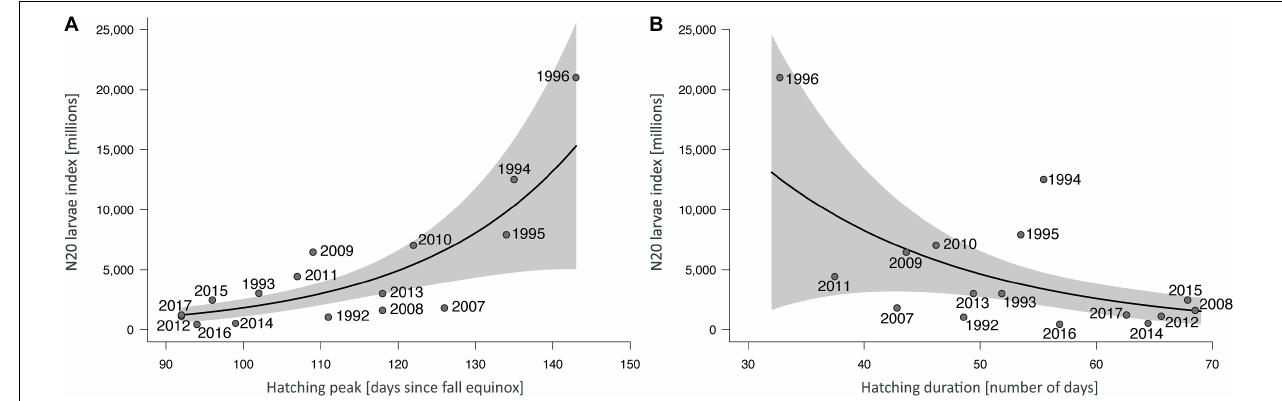
FIGURE 4 | (A) Predicted effect of the date of the hatching peak in the period from the autumn equinox (9/22) to the first solstice (6/21) on larval herring production (N20 larvae index), and (B) predicted effect of the hatching duration in the same period on larval herring production (N20 larvae index). Points represent the annual estimates of the variables related to the empirical value of the post-winter descriptors. Shaded areas represent 95% confidence intervals.